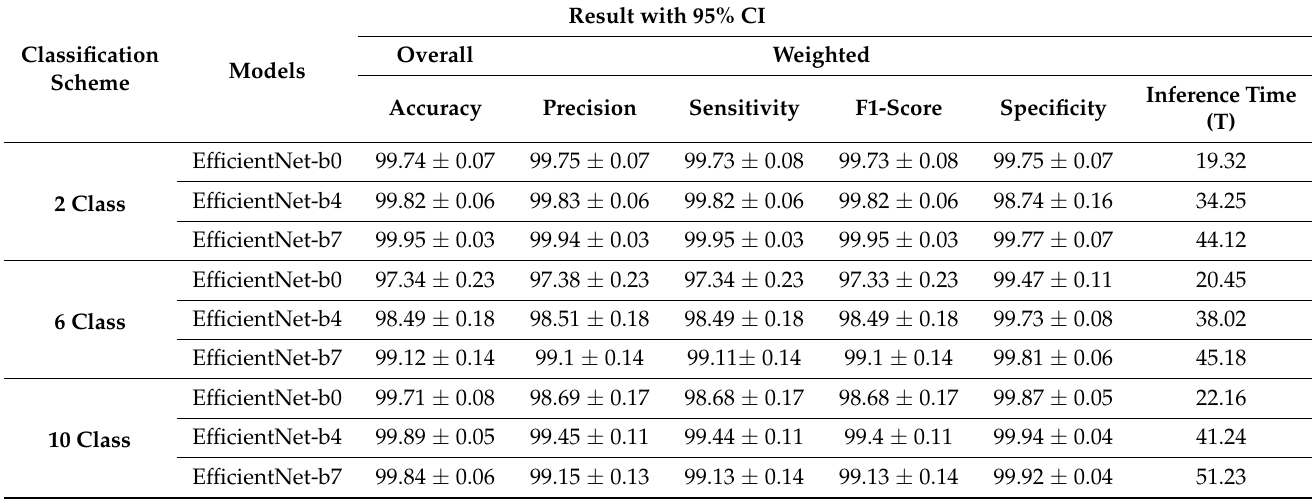
Figure 5. Samples tomato leaf images from a database ( left ), generated masks by the trained modified U-net model with NLL loss function (second from left ), corresponding segmented leaf (second from right ), and the ground truth from the database ( right ). Table 7. Summary of the tomato leaf disease classification performance using segmented and original leaf images. (Best results are highlighted as